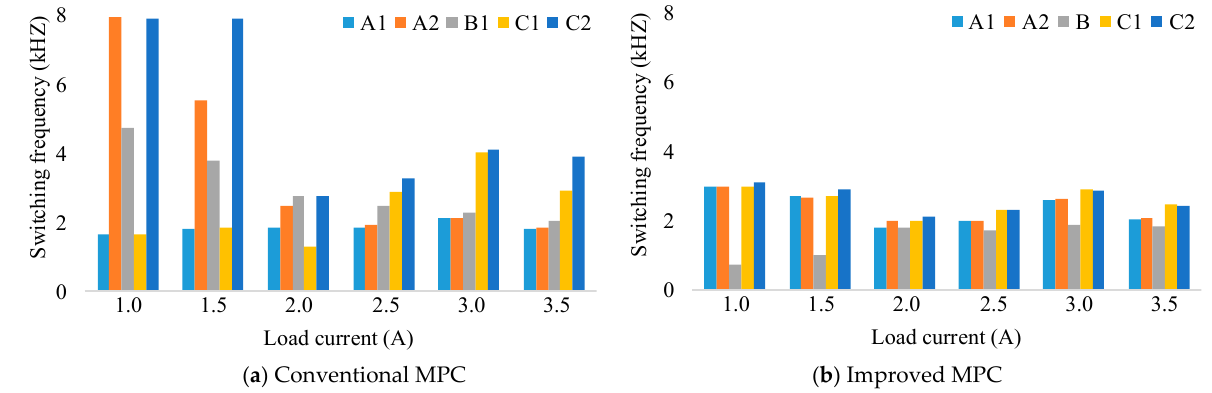
Figure 17. The switching frequency distribution among switching devices.